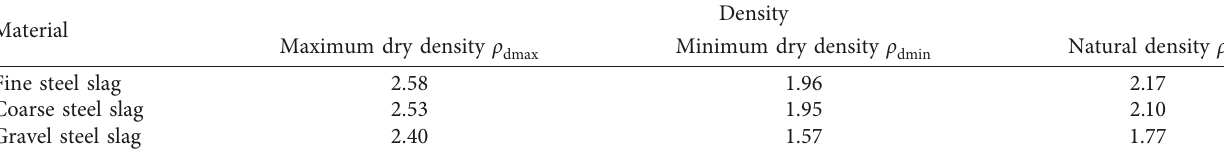
Table 3: Maximum and minimum dry densities of three kinds of steel slag (g/cm 3